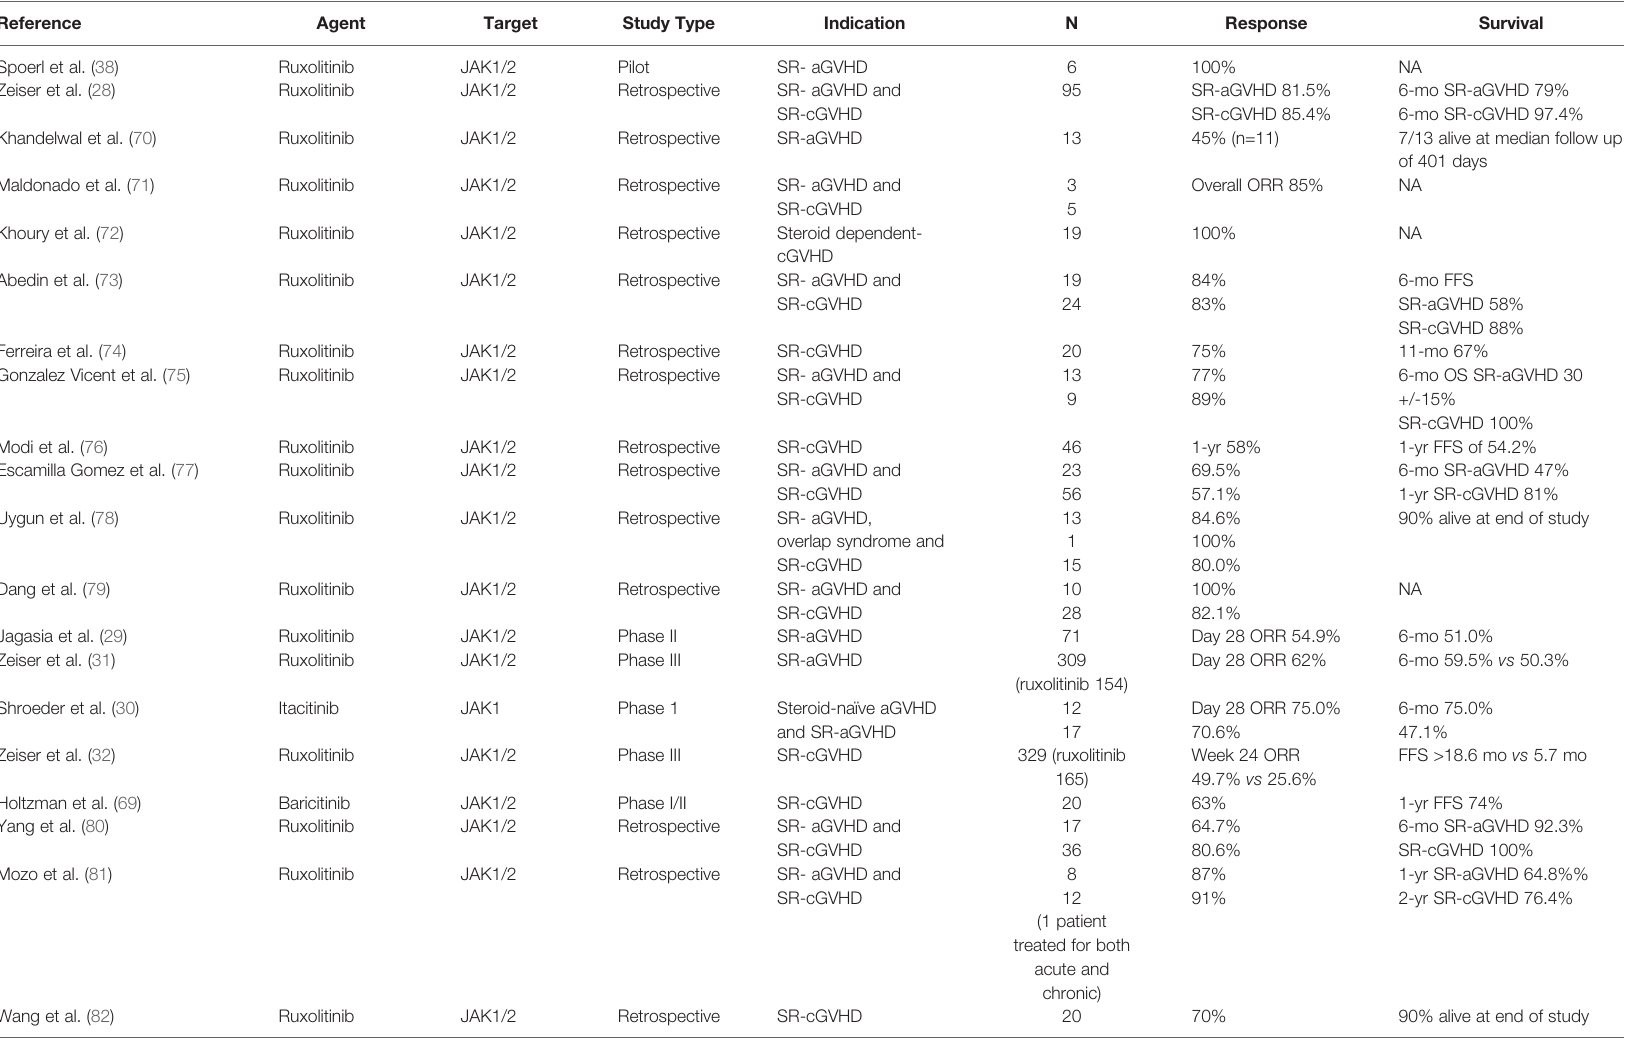
TABLE 1 | Clinical studies of JAK inhibitors for the treatment of refractory